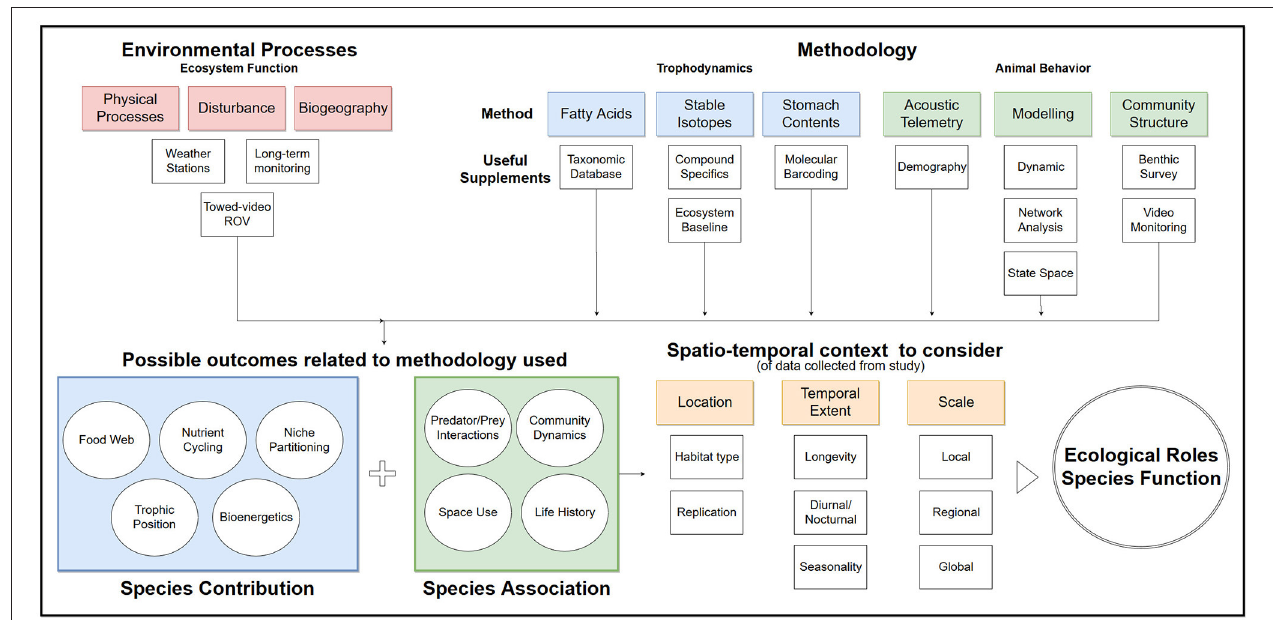
FIGURE 2 | Flow chart of suggested process to inform ecological roles from common methodology used in trophodynamic study for species in coral reefs.